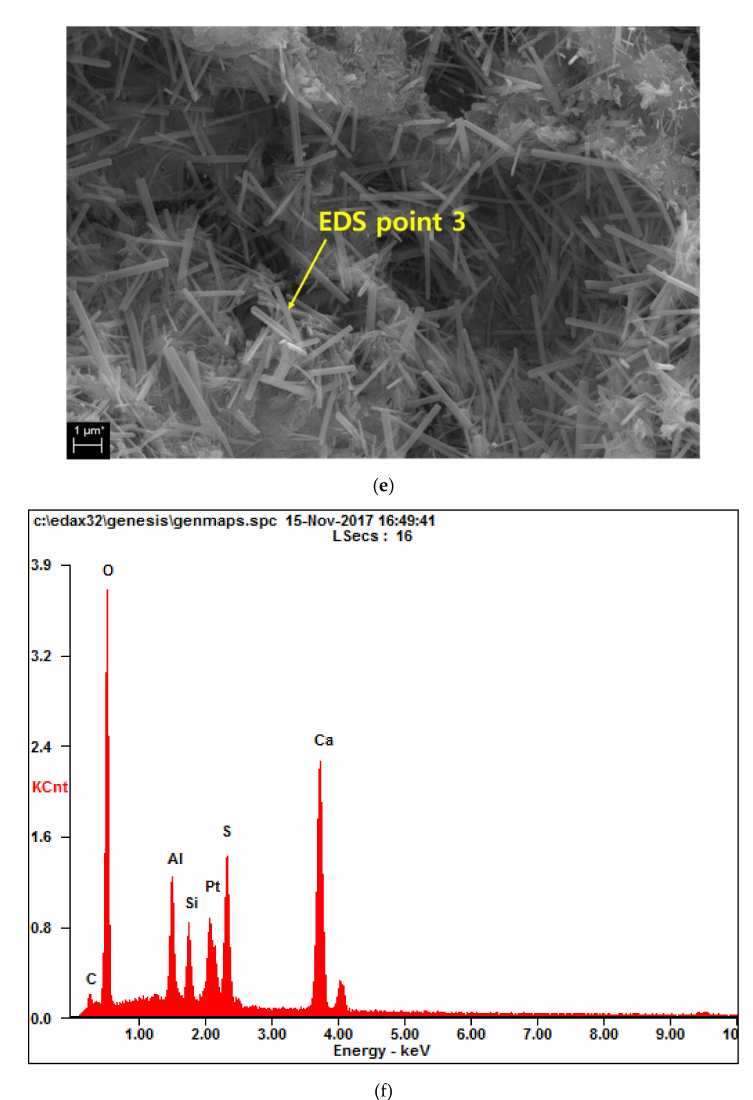
Figure 6. SEM images at 28 d, ( a ) G80F10C10, ( b ) EDS result of ettringite (EDS point 1), ( c ) G70F10C20, ( d ) EDS result of ettringite (EDS point 3), ( e ) G60F10C30, and ( f ) EDS result of ettringite (EDS point